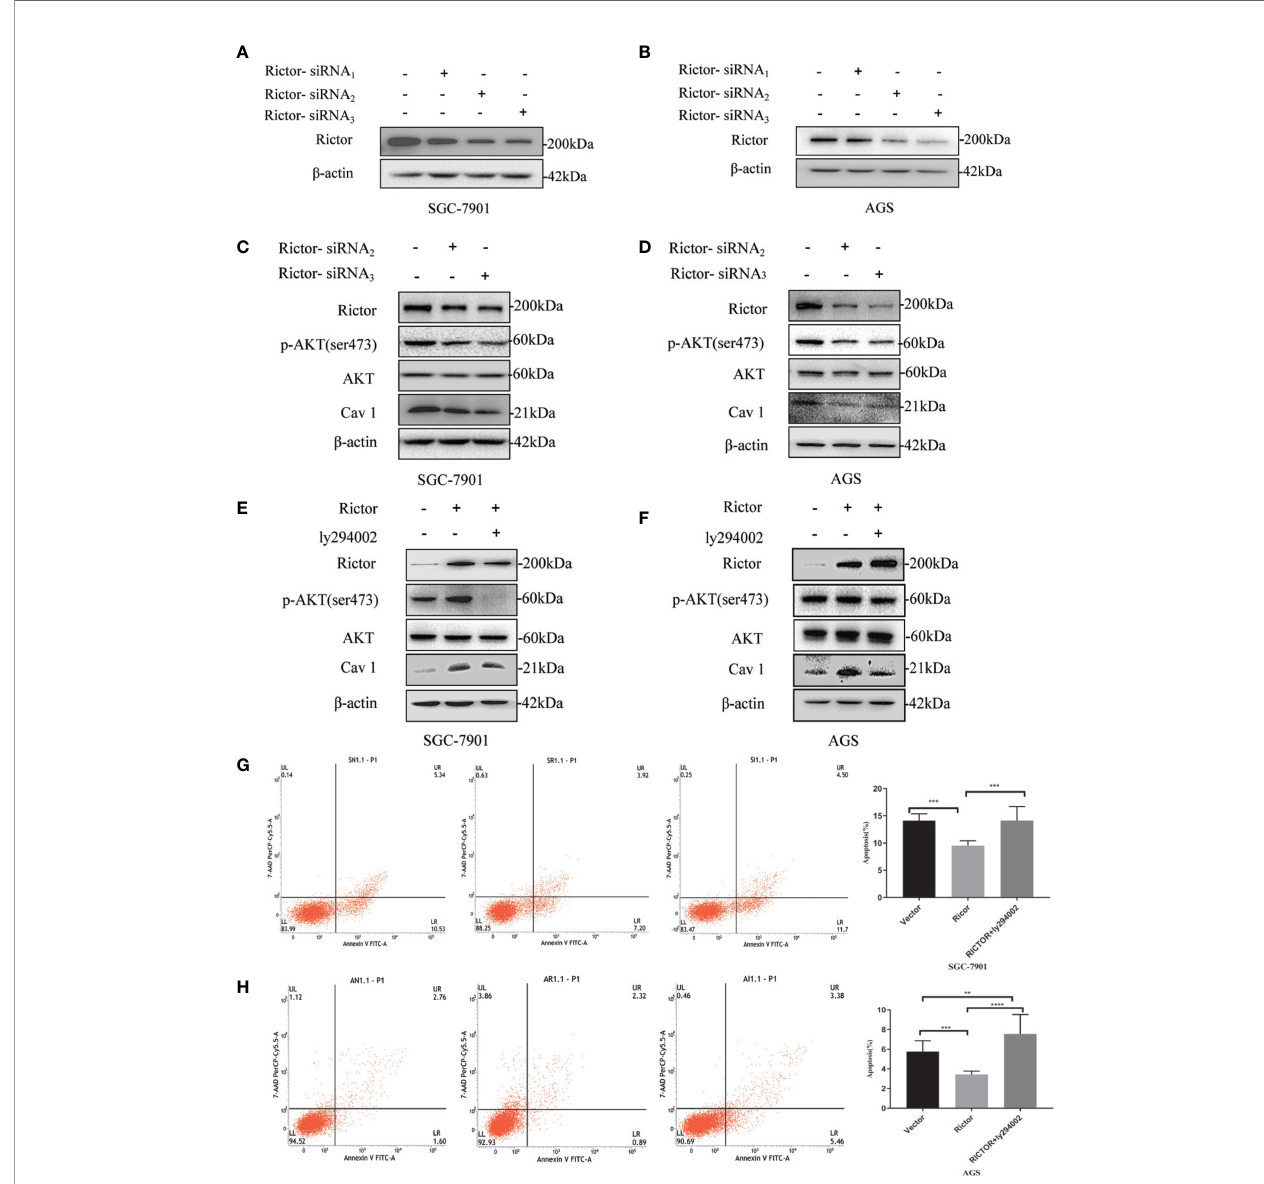
FIGURE 5 | Association between Rictor and Cav 1 analyzed using western blot and apoptosis detection. (A, B) Two different cell lines were transfected with Rictor- siRNA respectively to verify Rictor-siRNA knock down ef fi ciency. (C) Protein levels of p-Akt and Cav 1 induced by Rictor knockdown in SGC-7901 cells were assessed. (D) Protein levels of p-Akt and Cav 1 induced by Rictor knockdown in AGS cells. (E) After transfection of Rictor plasmid in SGC-7901 cells for 24 h and addition of 20 m M ly294002 for 6 h, the changes of p-Akt and Cav 1 protein levels were detected by western blot. (F) After transfection of Rictor plasmid into AGS cells for 24 h, and addition of 20 m M ly294002 for 6 h, the changes of p-Akt and Cav 1 protein levels were detected by western blot. b -actin served as loading control. (G) Apoptosis of SGC-7901 cells after 24 h transfection with Rictor plasmid and 24 h treatment with 20 m M ly294002 (n=3). (H) Apoptosis of AGS cells after 24 h transfection with Rictor plasmid and 24 h treatment with 20 m M ly294002 (n=3). Values represent the Means ± SD. **P < 0.01, ***P < 0.001 and ****P < 0.0001 were calculated using Student ’ s